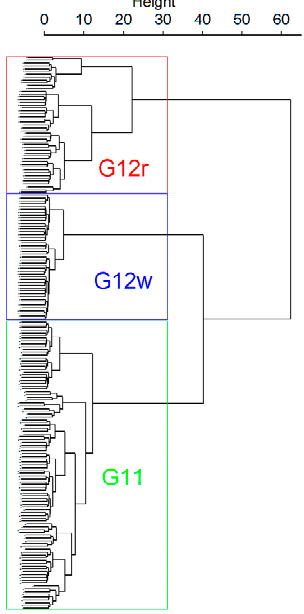
Figure 10. Dendrogram for grouping the entities based on their usage characteristics.